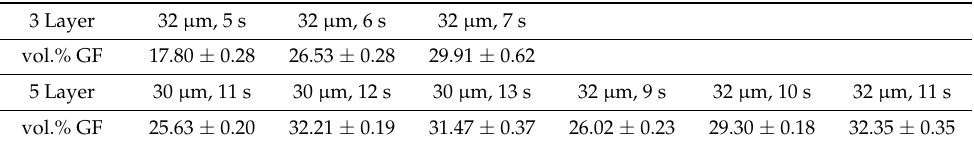
Figure 8. Illustration of energy directing effect of fibers in ultrasonic impregnation.